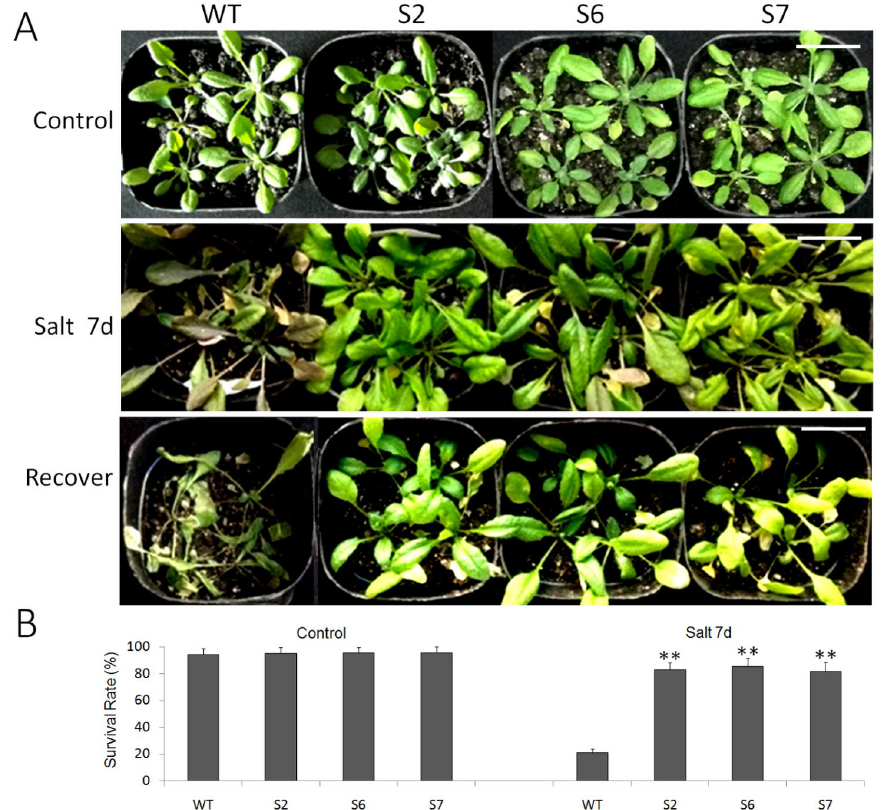
Figure 7. The overexpression of VvWRKY28 improved the salt tolerance of Arabidopsis . ( A ) The phenotype of WT and transgenic plants after salt stress and recovery. The ruler stood for 3 cm. ( B ) Survival rates of WT and transgenic lines under normal and salt conditions. The T test showed that, under salt stress, there was a very significant difference between transgenic lines and WT, ** p ≤ 0.01.